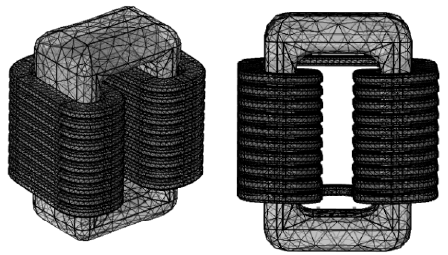
Figure 7. Reactor mesh generation.